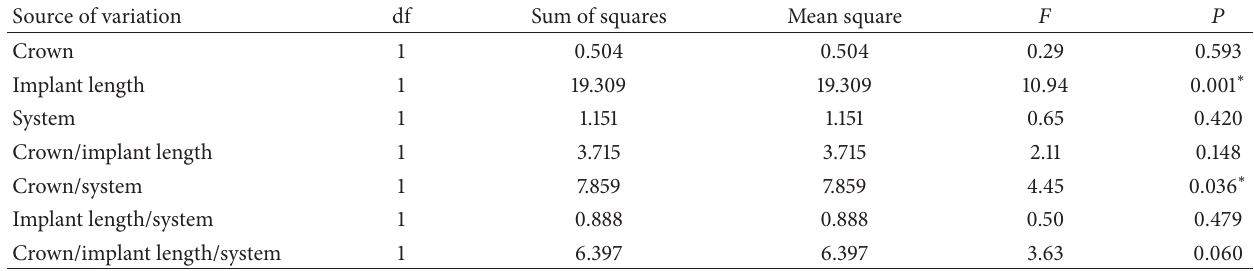
Table 3: Three-way ANOVA for stress distribution under nonaxial loading, based on the factors crown height, length, and implant system. Source of variation df Sum of squares Mean square Crown Implant length